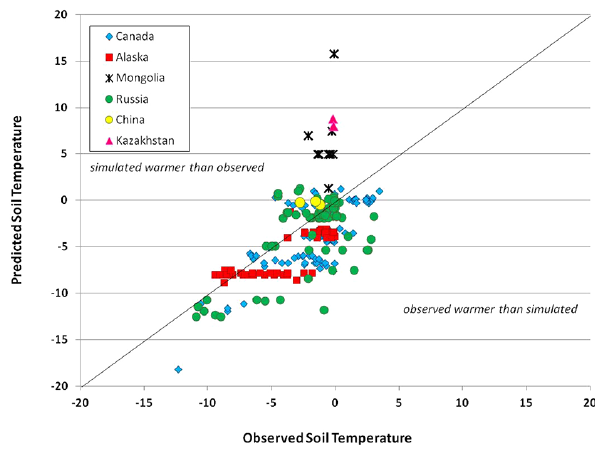
Figure 11. A 1 : 1 scatter plot comparing simulated mean annual temperatures with corresponding MAGT